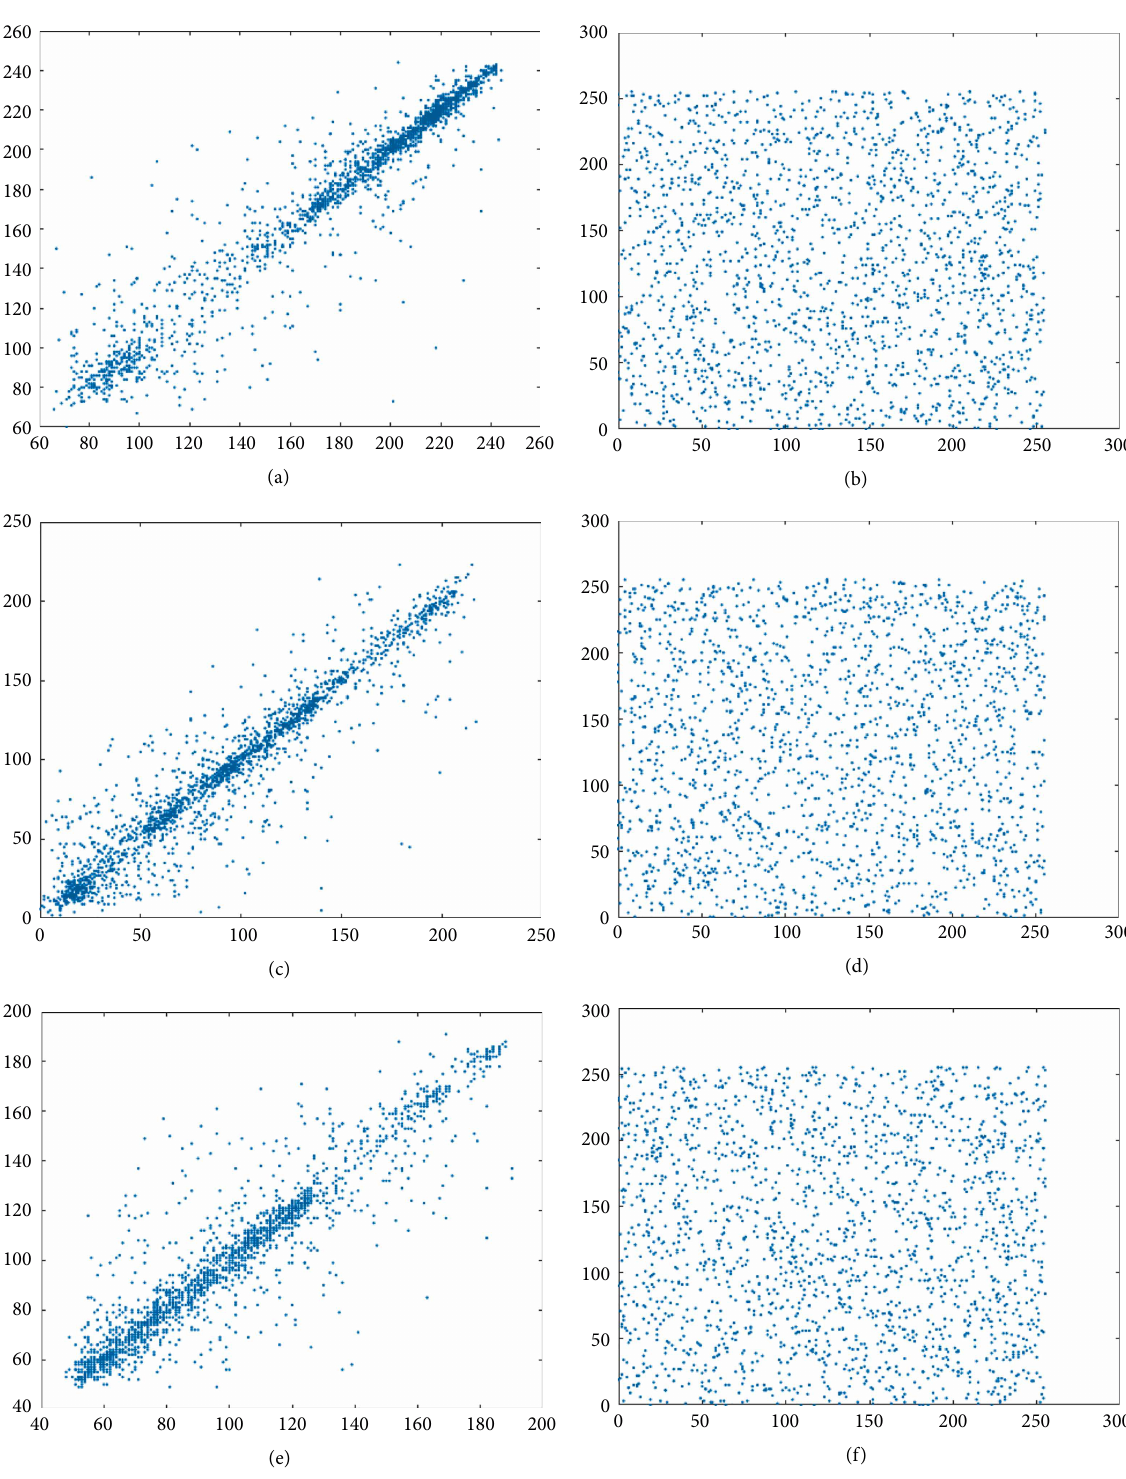
Figure 16: Horizontal correlation of original image. (a, c, e) are the correlation of original image in 𝑅 𝐺 , and 𝐵 , respectively; (b, d, f) are the correlation of encrypted image in 𝑅 𝐺 , and 𝐵 ,